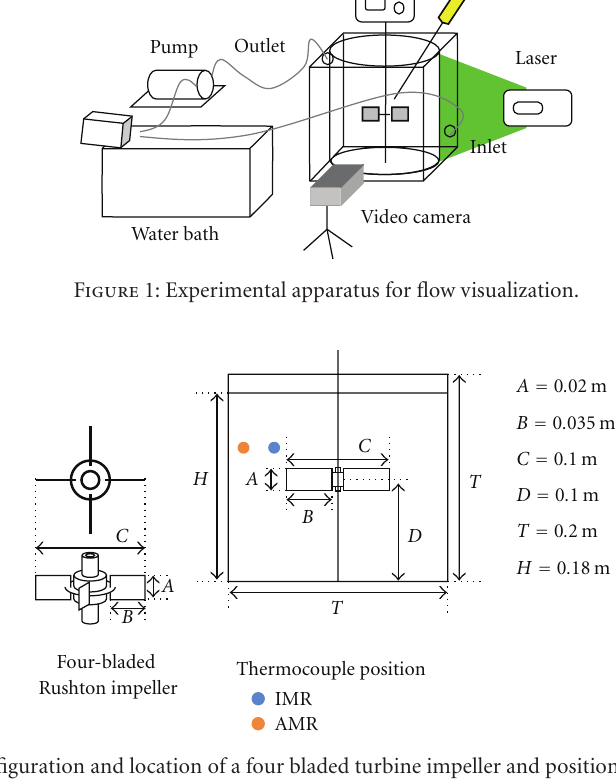
Figure 2: Configuration and location of a four bladed turbine impeller and position of